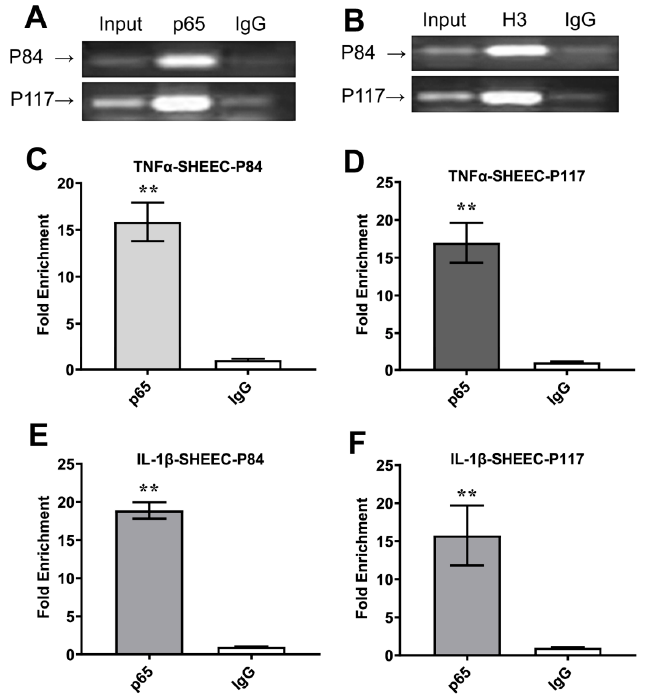
Figure 5. ChIP analysis of NF- κ B TF binding to the BIRC3 gene. In vivo NF- κ B ( A ) and acetylate histones H3K27Ac ( B ) binding to the BIRC3 gene in SHEEC cell lines. Diluted samples from ChIP inputs were analyzed by PCR in parallel (lane 1), and lane 3 showed the negative control in the presence of rabbits IgG. H3 indicated the addition of acetylate histones H3K27Ac. ( C , D ) and ( E , F ), the fold enrichment of BIRC3 genes interacted with NF- κ B compared with IgG in SHEEC cell lines treated by 30 ng/mL TNF α and 20 ng/mL IL-1 β , respectively. P84 and P117 indicated the length of BIRC3 fragments. ** shows p < 0.01.